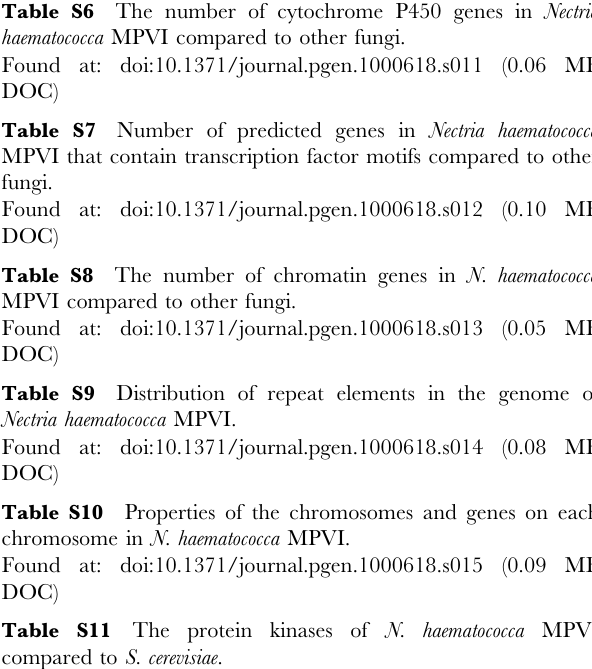
Table S6 The number of cytochrome P450 genes in Nectria haematococca MPVI compared to other fungi.